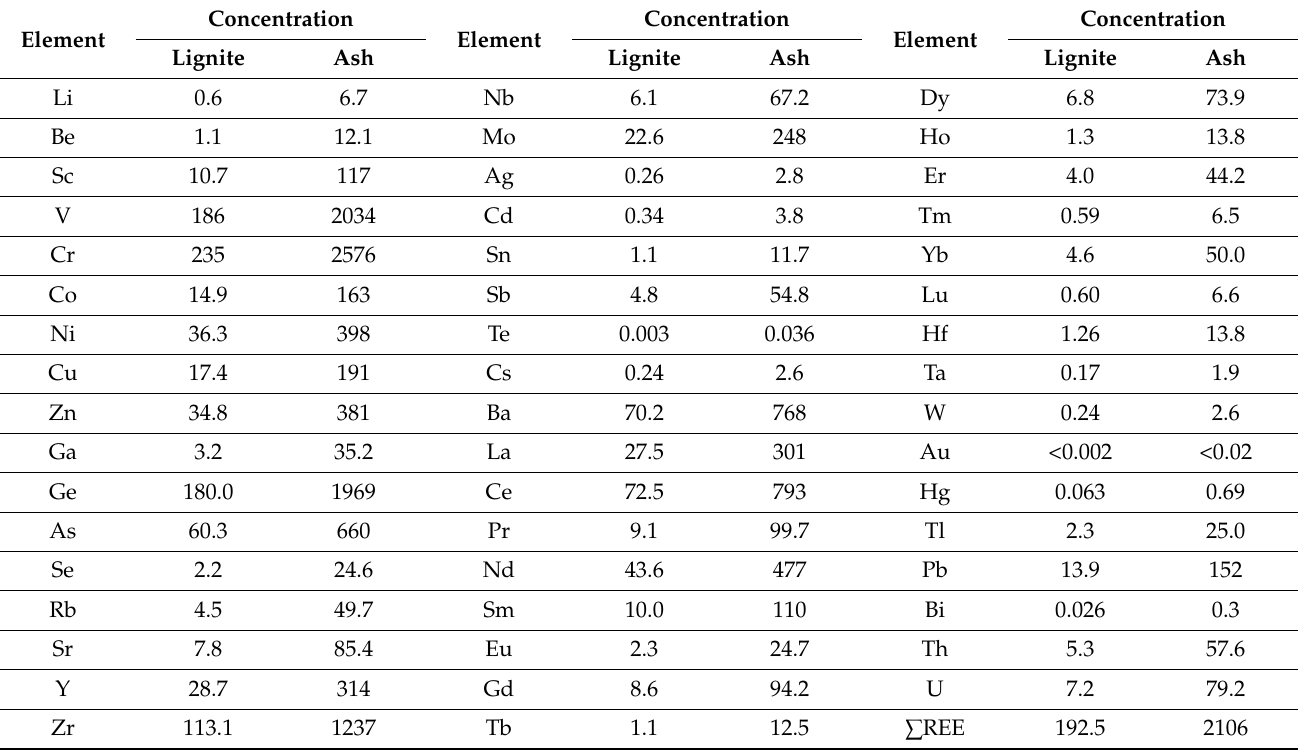
Table 3. The content of elements in lignite and lignite ash * from the Nizhne-Kas area (ppm, analyzed by